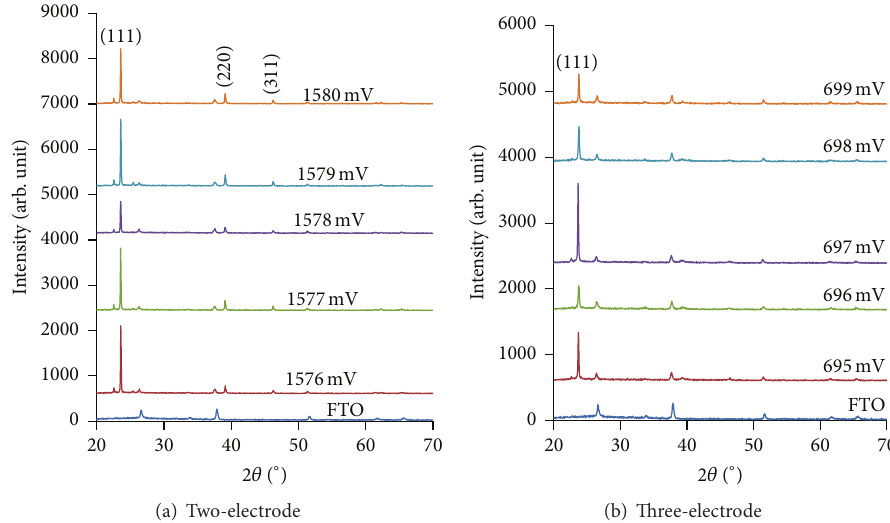
Figure 3: XRD patterns of CdTe layers grown at different cathodic voltages for 1 hour using (a) two-electrode system and (b) three-electrode system and annealed at 450 ∘ C for 15